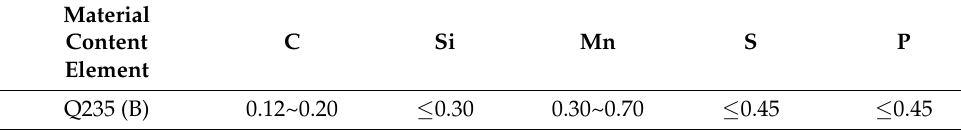
Table 2. Main chemical composition of Q235 galvanized steel (%) [16].